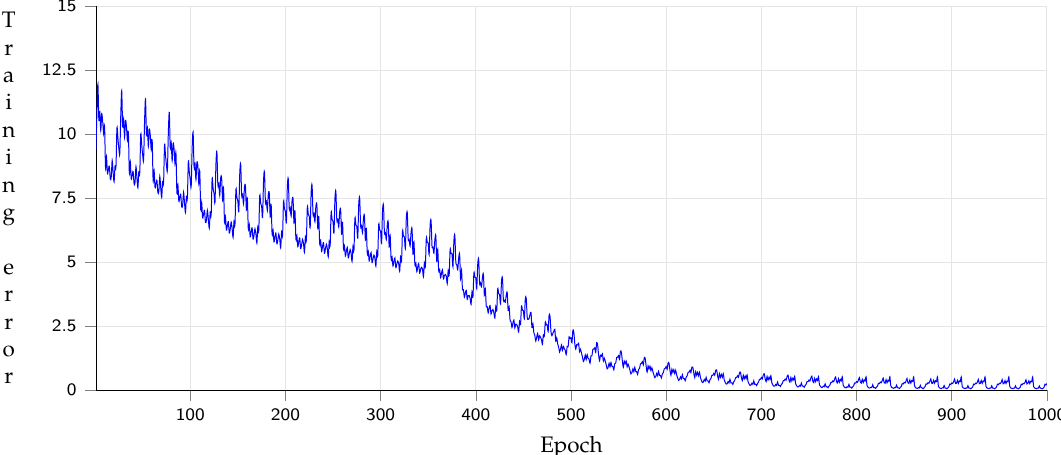
Figure 25. Training behavior of auto-encoder approach using navigation meshes and full path.